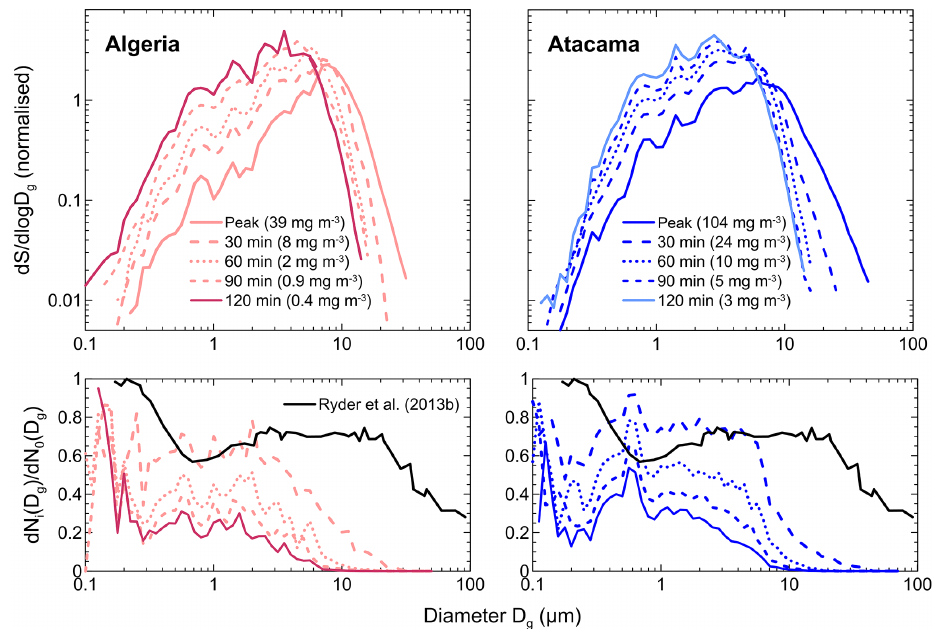
Figure 7. Upper panel: surface size distribution measured at the peak of the dust injection and at 30, 60, 90, and 120min after injection for the Algeria and Atacama aerosols. The dust mass concentration is also indicated in the plot. Lower panel: fraction of particles remaining airborne in the chamber as a function of time versus particle size calculated as d N i ( D g ) /d N 0 ( D g ) , where d N i ( D g ) is the number of particles measured by size class at time i ( i corresponding to 30, 60, 90, and 120min after injection) and d N 0 ( D g ) represents the size-dependent particle number at the peak of the injection. Values are compared to the estimate of Ryder et al. (2013b) for Saharan dust layers aged 1–2 days after emission.